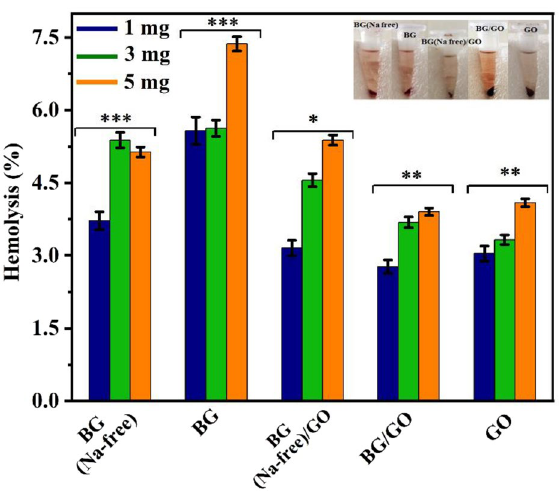
Figure 5. Hemolysis assay for BG, BG (Na-free), GO and BG/GO, BG (Na-free)/GO nanocomposites for varying concentrations and inserted photographs of haemolysed samples. The asterisks indicate significant